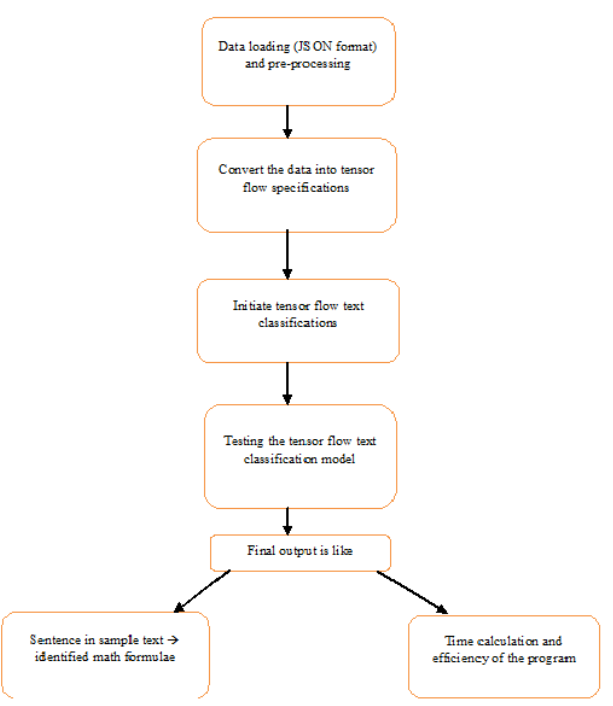
Table 2. The above tabulated value represents Overall Efficiency Measure with Tensorflow from a document of 40 samples.